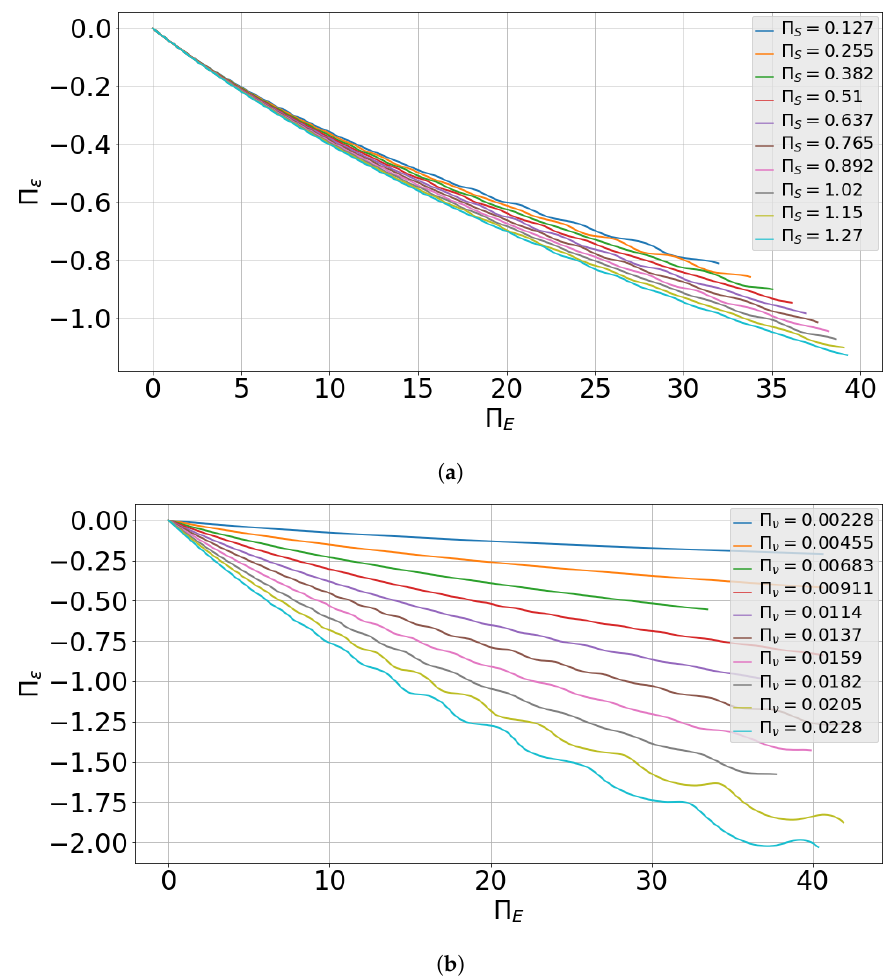
Figure 9. Variation of non-dimensional energy dissipation rate with dimensionless energy for ( a ) different values of Π S while keeping Π p = 69 and Π ν = 0.0114 constant and ( b ) different values of Π ν while keeping Π p = 69 and Π S = 0.64